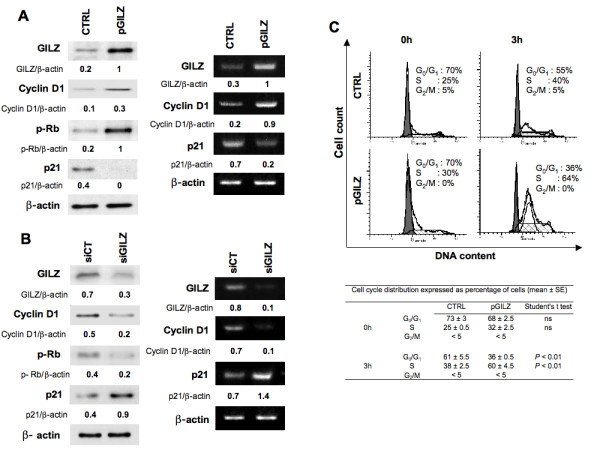
GILZ controls cyclin D1 and p21 expression. (A) Left: cyclin D1, phosphorylated retinoblastoma (p-Rb) and p21 were measured by western blot in CTRL and in pGILZ clones. β-actin was used as a loading control. Right: the steady-state levels of cyclin D1 and p21 mRNAs were assayed by semi-quantitative RT-PCR in CTRL and in pGILZ clones; β-actin was used as a loading control. (B) p21 and cyclin D1 gene products were measured by western blot (left) or by semi-quantitative RT-PCR (right) 48 h after BG-1 cells were transfected with 4 μg of control (siCT) or GILZ-specific (siGILZ) siRNA; β-actin was used as a loading control. Blots: one representative experiment of three. (C) Top: CTRL and pGILZ clones were synchronized by double thymidine block. Following removal of the block, cells were analyzed for DNA content by PI staining and cell cycle distribution was analyzed by flow cytometry at various time points; the percentages of cells in different cycle phases were determined by ModFit Cell Cycle Analysis software. Data are representative of three independent experiments. Bottom:Percentage of cells in each phase of the cell cycle. Results from three independent experiments (mean ± SE). Unpaired Student's t test was used for comparisons.